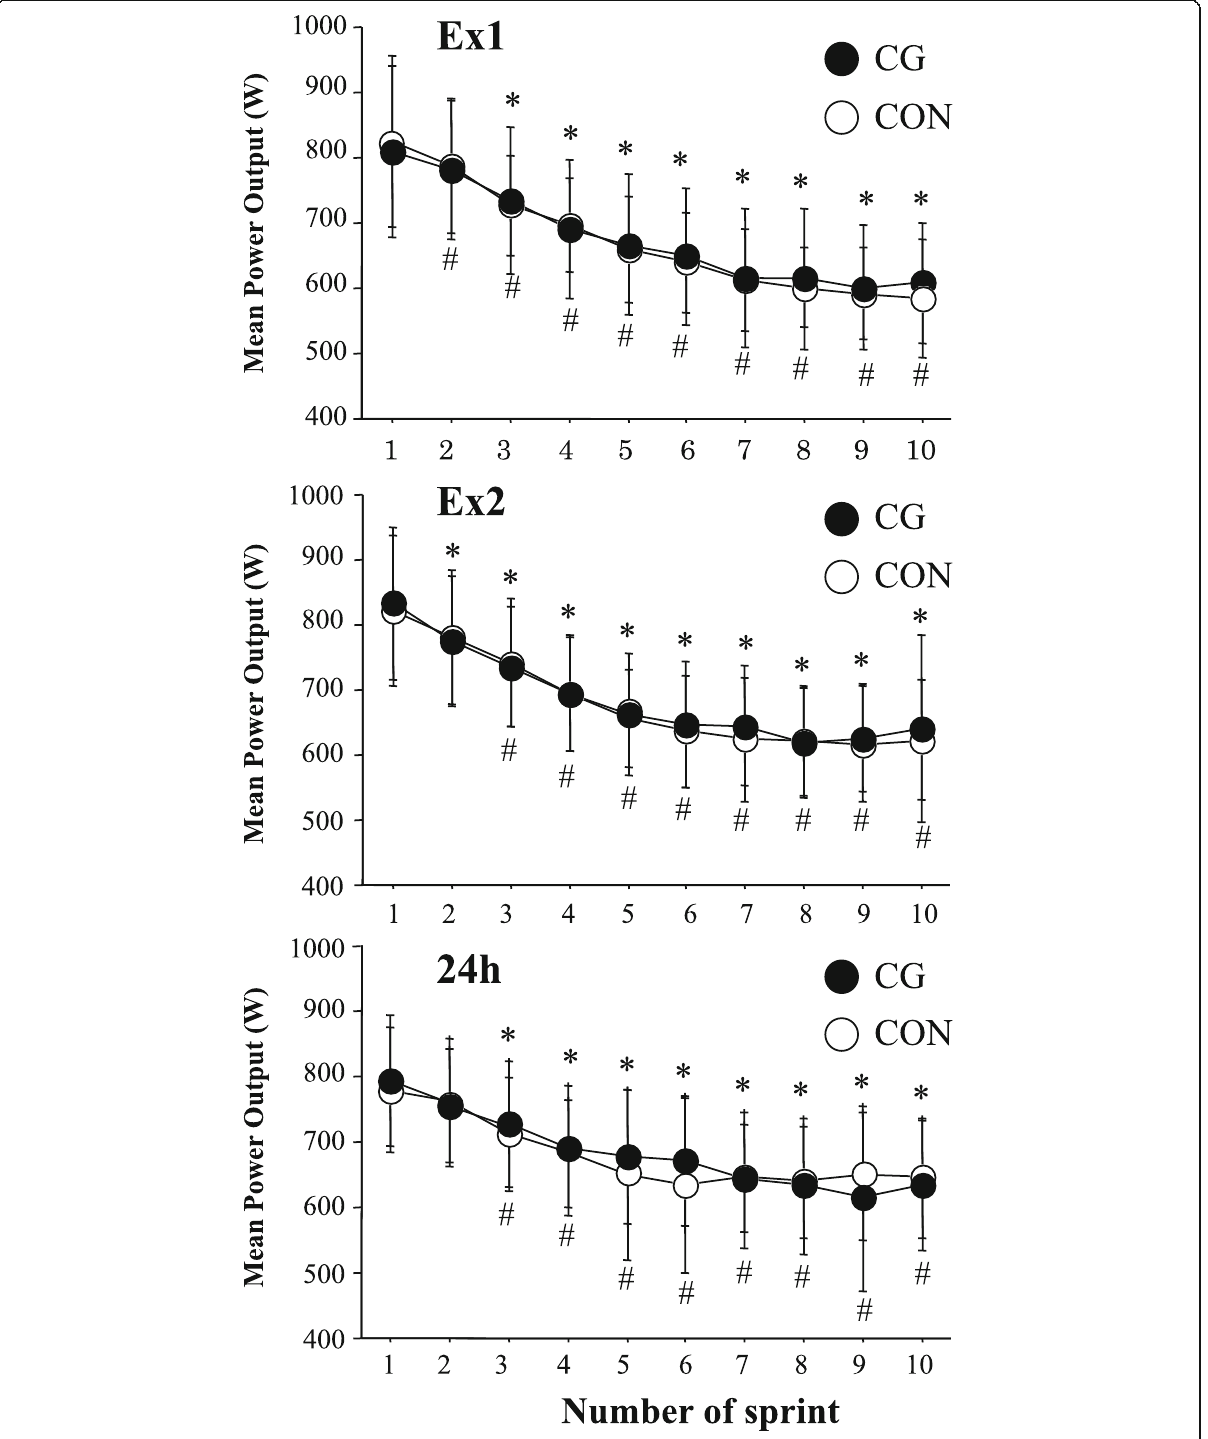
Fig. 4 Power output during repeated sprint test. Values are means ± SD. * P < 0.05 vs. the value in the first sprint (CG); # P < 0.05 vs. the value in the first sprint